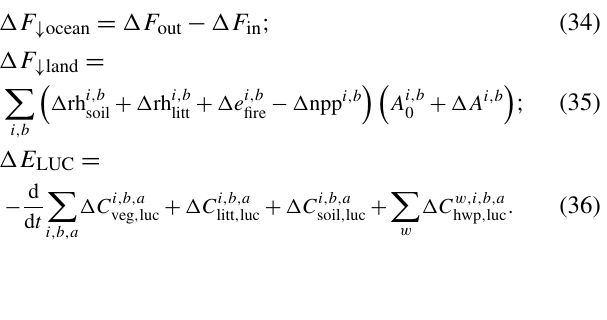
◦ d = − τ w C w ] ln [ hwp hwp d t